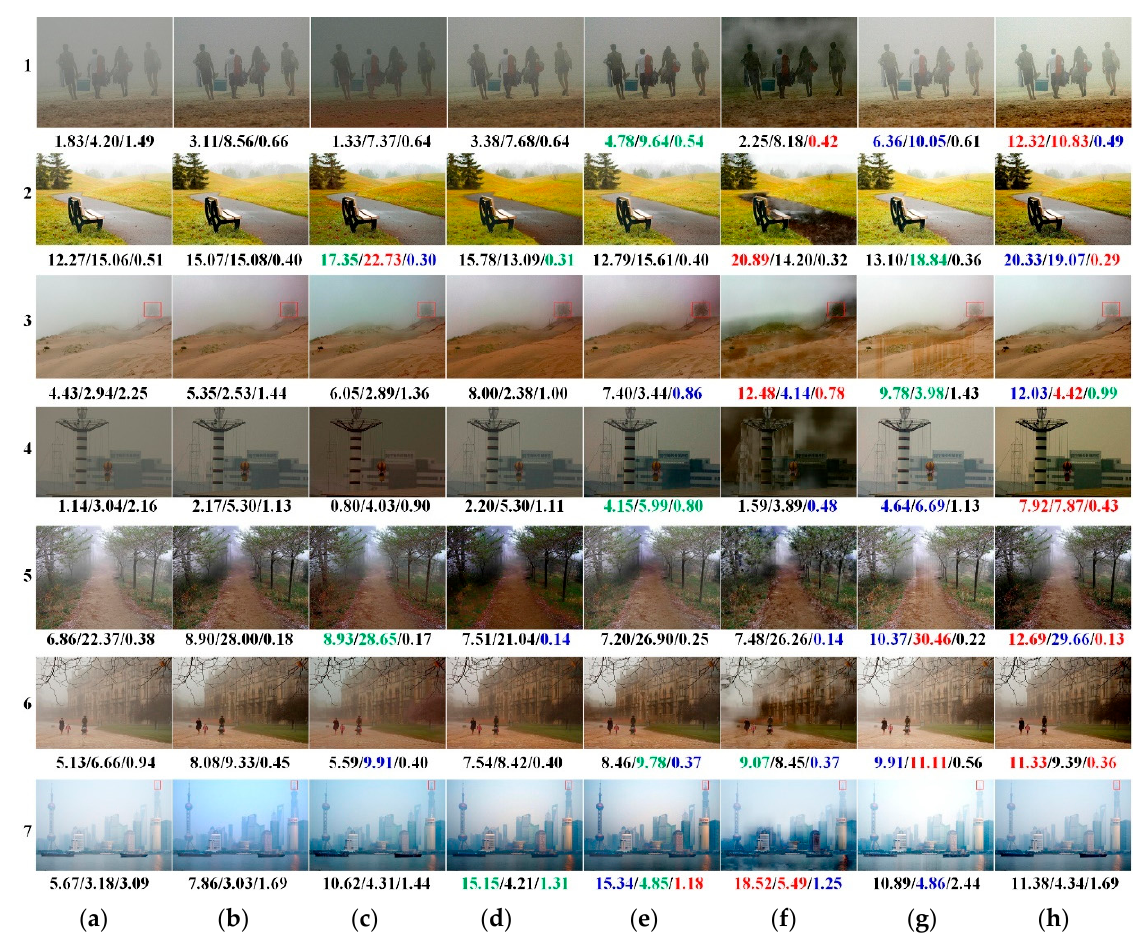
Figure 6. Qualitative comparisons on the LIVE foggy outdoor dataset [33] with average gradient (AG), image entropy (IE), and the fog-aware density evaluator (FADE) values listed below each image. The 1st, 2nd, and 3rd winners of each measurement are displayed in red, blue, and green colors, respectively. ( a ) Hazy Inputs; ( b ) DehazeNet [6]; ( c ) AOD [8]; ( d ) colour attenuation priors (CAP) [2]; ( e ) proximal dehazing network (PDN) [10]; ( f ) grid dehazing network (GDN) [11]; ( g ) F-DCP [15]; ( h ) TGL-Net-Mix.